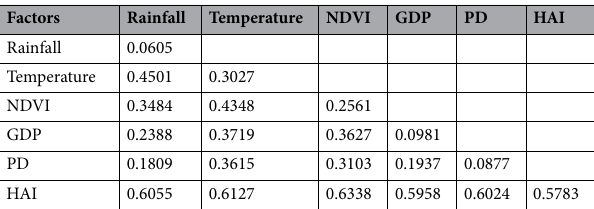
Table 6. Interaction detection for spatial heterogeneity of carbon